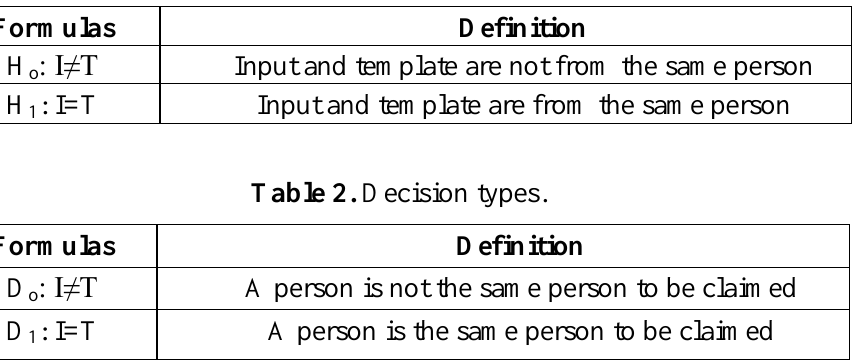
Table 1. The null and the alternate hypotheses for the biometric verification.